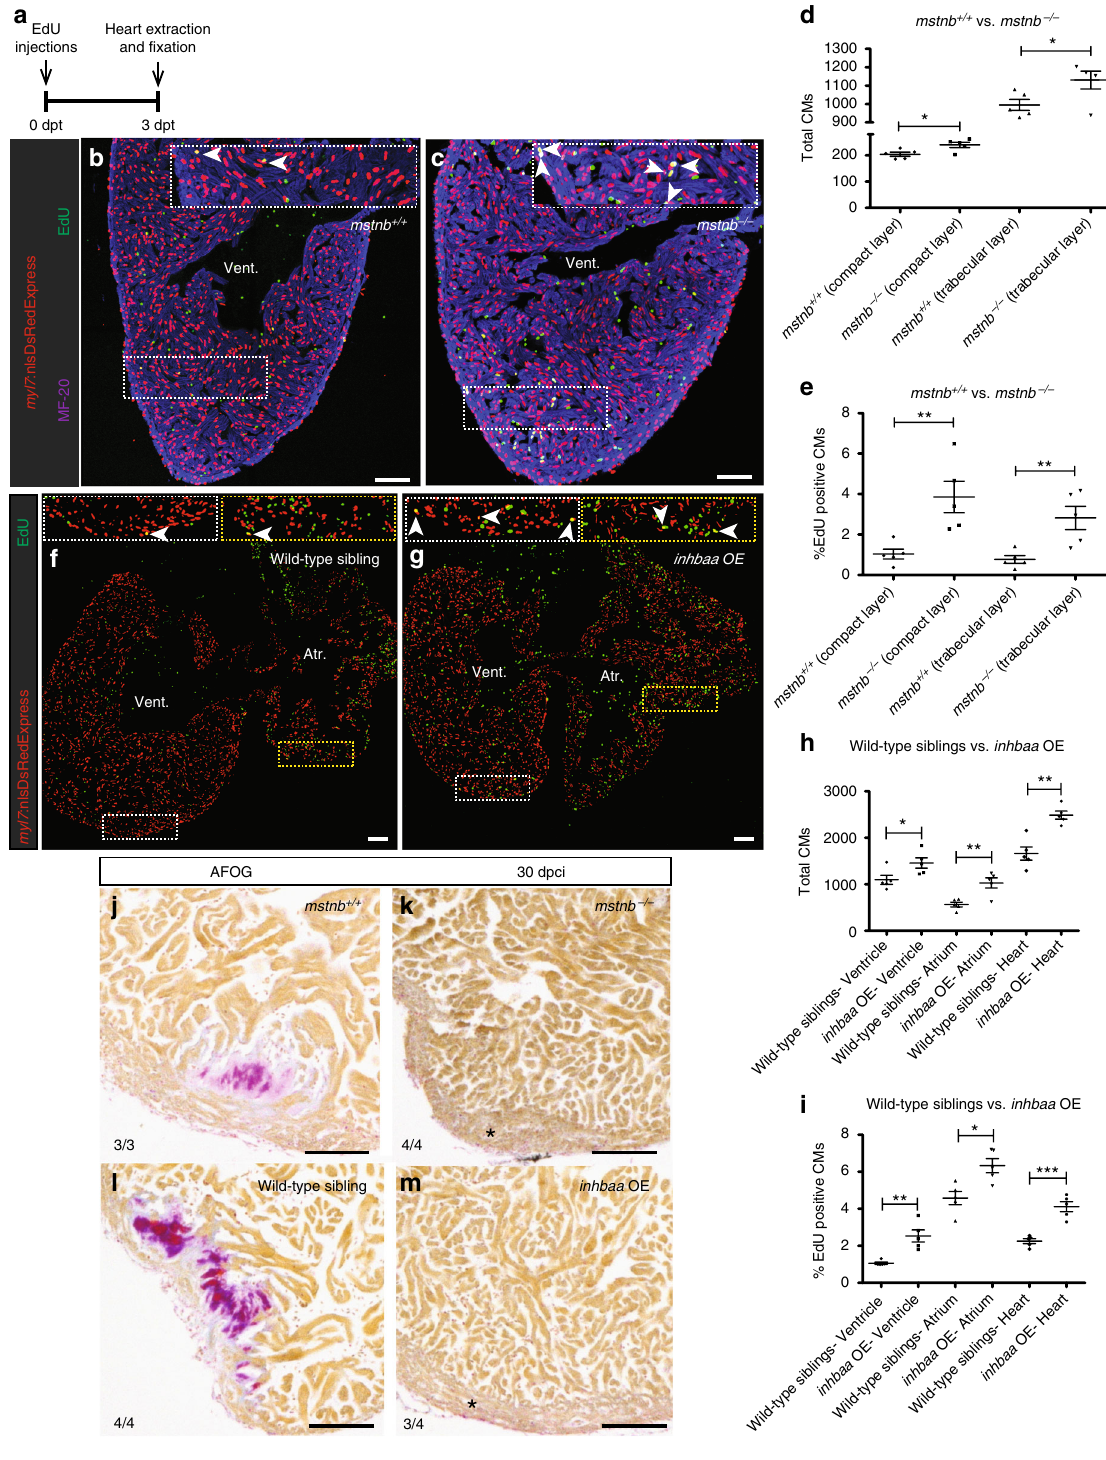
Wild-type siblings vs. inhbaa